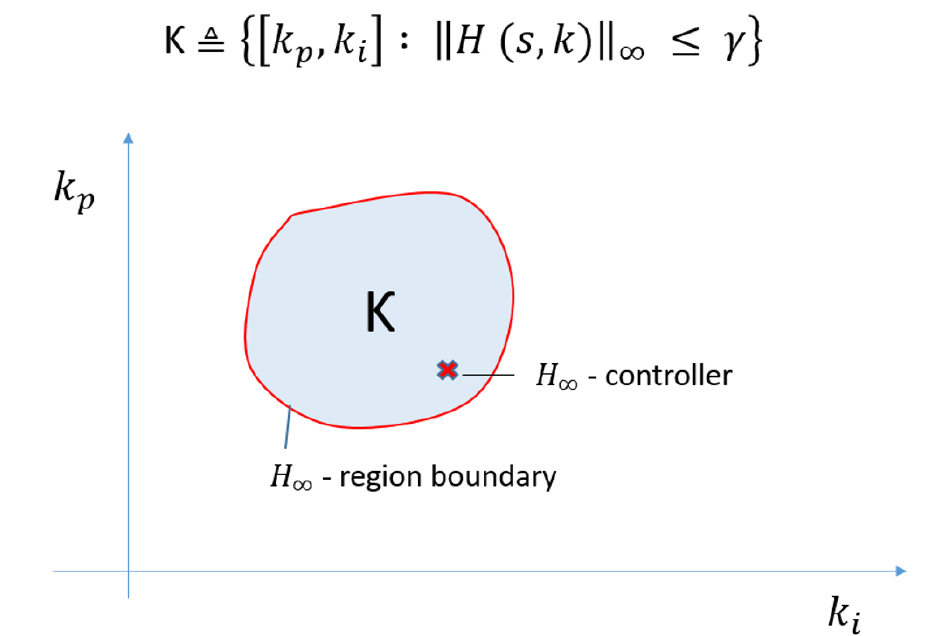
Figure 8. H ∞ controller-admissible set of controller gains fulfilling the formulated loopshaping inequality constraint in the parametric